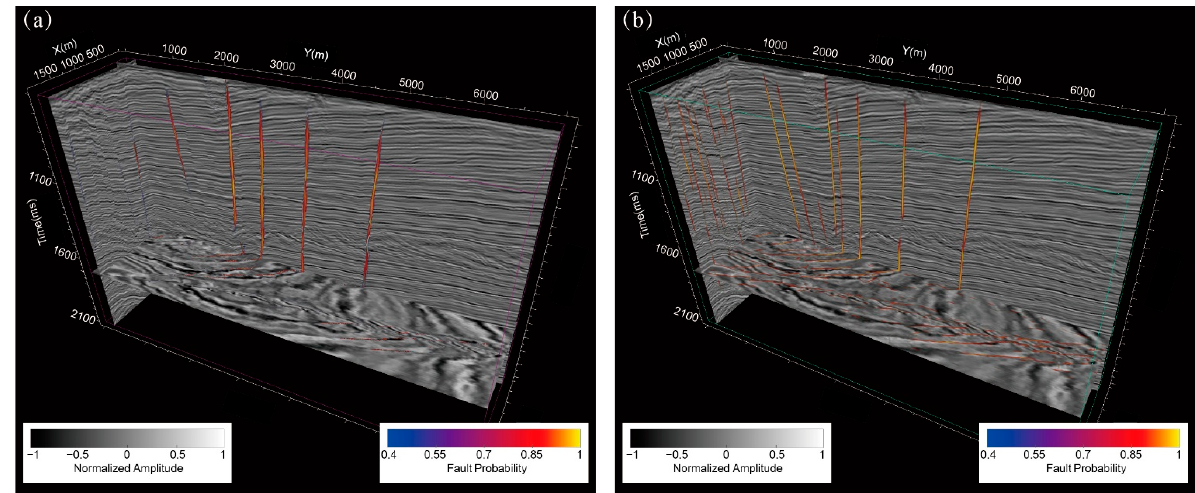
Figure 11. A subset of Kerry-3D seismic data is displayed with faults probabilities that are predicted by using ( a ) the pre-trained U-Net model and ( b ) the U-Net model after transfer learning.